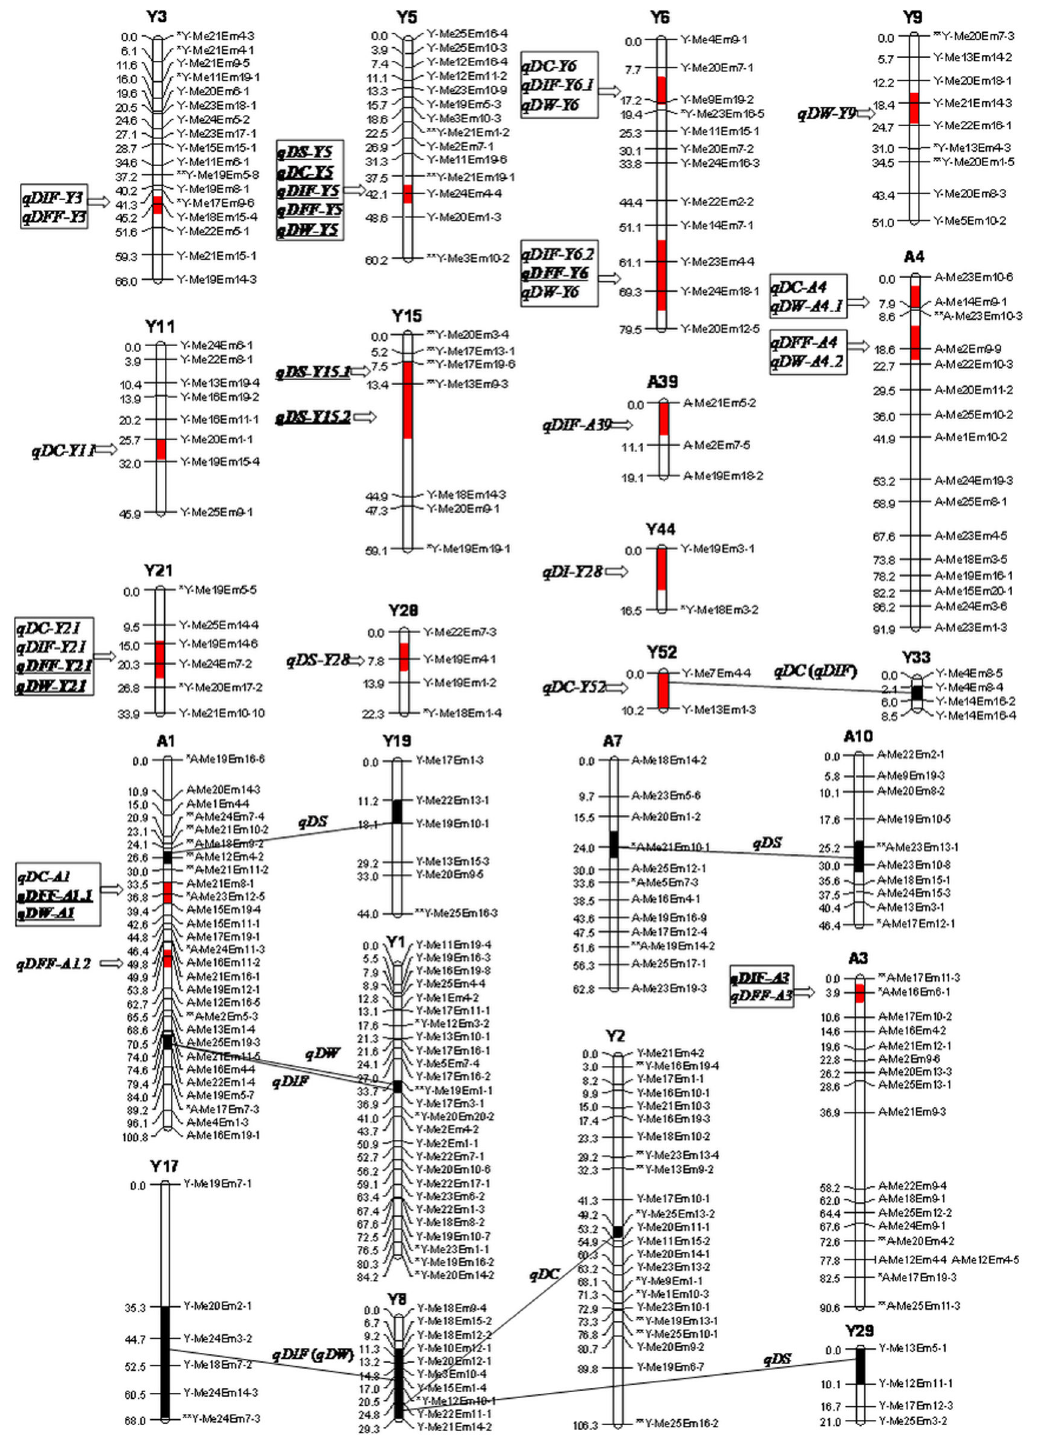
Figure 1. Graphical representation of additive and epistatic QTL for selected flowering time traits. Loci shown in bold and underlined represent those detected in both cropping years. Lines linking pairs of loci indicate additive x additive epistatic QTL. Genomic regions outlined in red harbor QTL with additive effects, whereas those in black harbor those which interact epistatically. Genomic regions containing QTL clusters are boxed. Days from transplanting to squaring (DS), coloring (DC), initial flowering (DIF), full flowering (DFF) and inflorescence wilting (DW). ** Significant distorted segregating at P < 0.01. doi: 10.1371/journal.pone.0083023.g001 PLOS ONE |